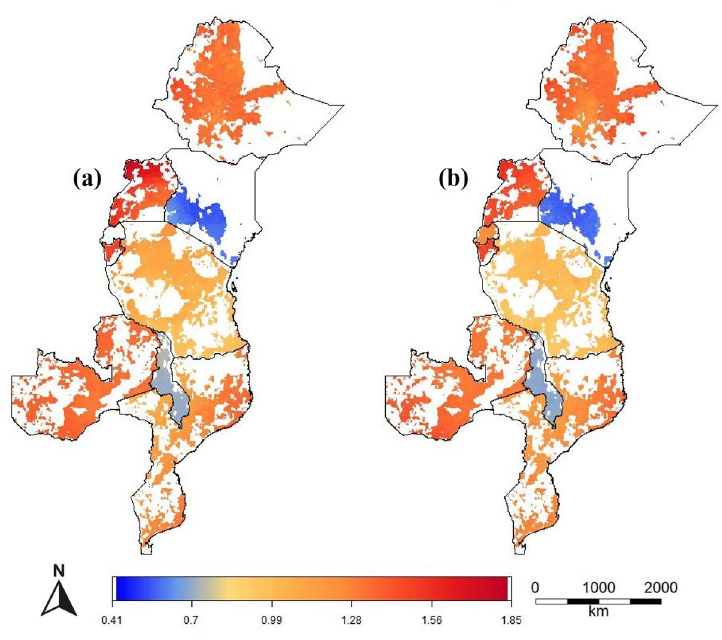
Fig 9. Urea price (USD kg -1 ) for crop land in East African countries predicted with (a) country level models; and (b) with a single regional